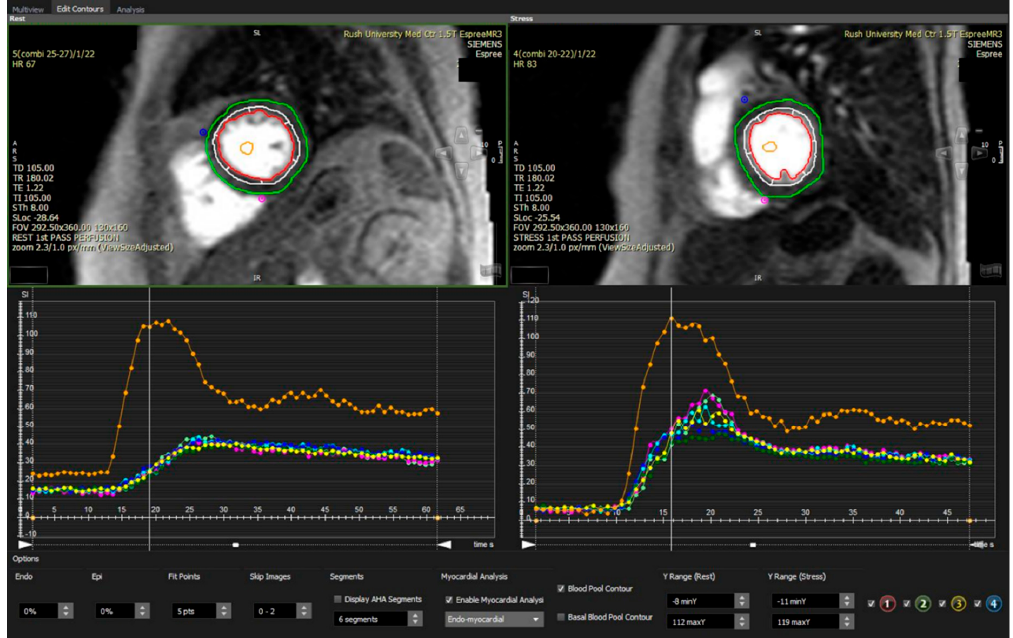
Figure 4. Stress CMR (Cardiovascular Magnetic Resonance) perfusion in a 67-year-old woman with angina and negative coronary CTA (computed tomography angiography) that had shown minimal calcific plaque with <10% stenosis in the proximal left anterior descending artery. After regadenoson stress, no visual reversible perfusion defect was noted, indicating the absence of ischemia from epicardial stenosis; however, the MPRI (myocardial perfusion reserve index) is computed at 1.97, consistent with the diagnosis of CMD (coronary microvascular dysfunction). She was initiated on amlodipine, a high intensity statin and long-acting nitrate therapy and had resolution of anginal symptoms after 2 weeks. In the top panel, Green contours depict epicardium of the left ventricle, Red depicts the endocardial border, and White is the mid myocardium. In the bottom panel, the Orange curve is the signal intensity of blood pool in the left ventricle plotted against time—during Stress regadenoson imaging on the right, and at Rest on the left. The other colored curves depict various segments of the left ventricular myocardium.